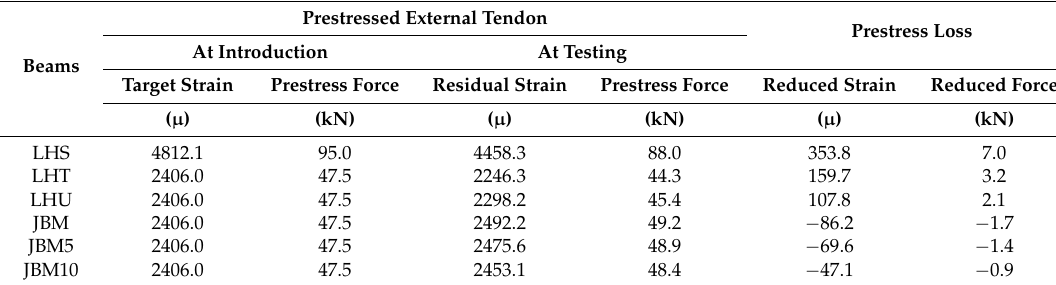
Table 2. Losses of prestress strain for one prestressing tendon.